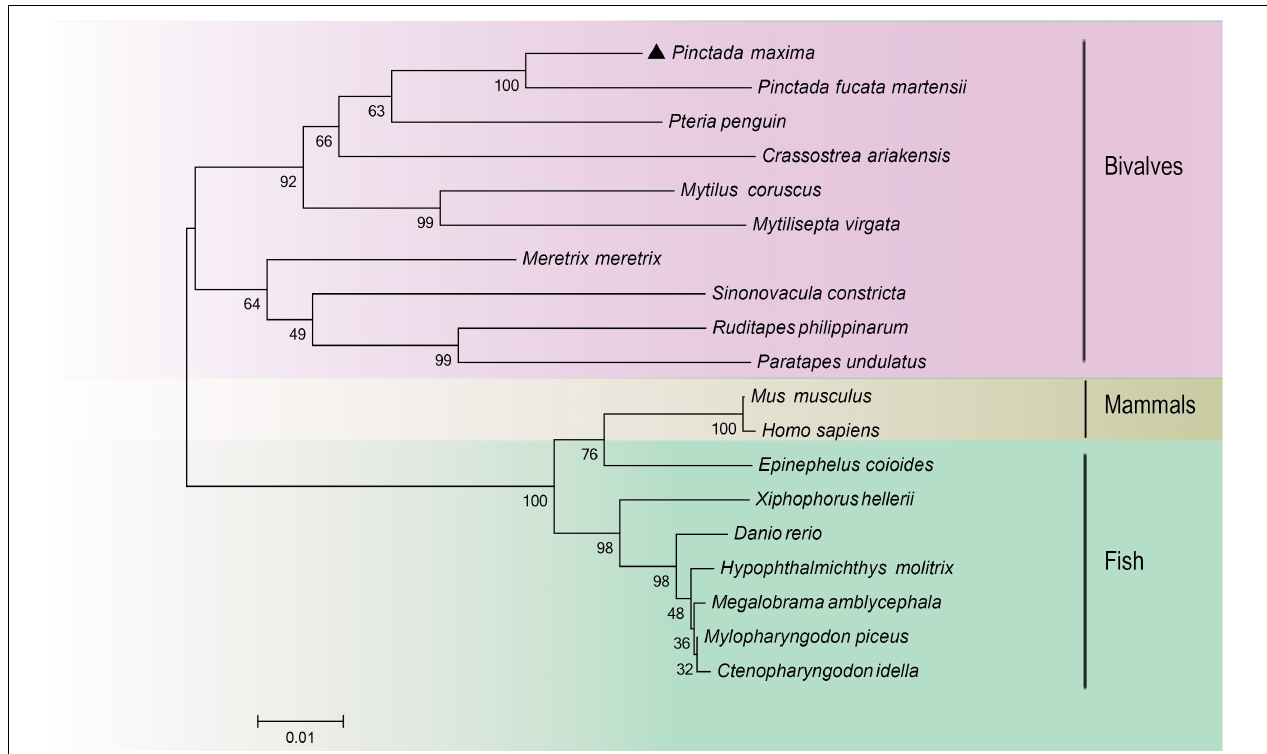
FIGURE 4 | A phylogenetic tree constructed using the neighbor-joining method based on amino acids sequence deduced from HSP70 of Pinctada maxima and other species. Pinctada maxima was labeled with “ (cid:78) ”. The GenBank accession numbers of all the HSP70 were shown in Table 2 .